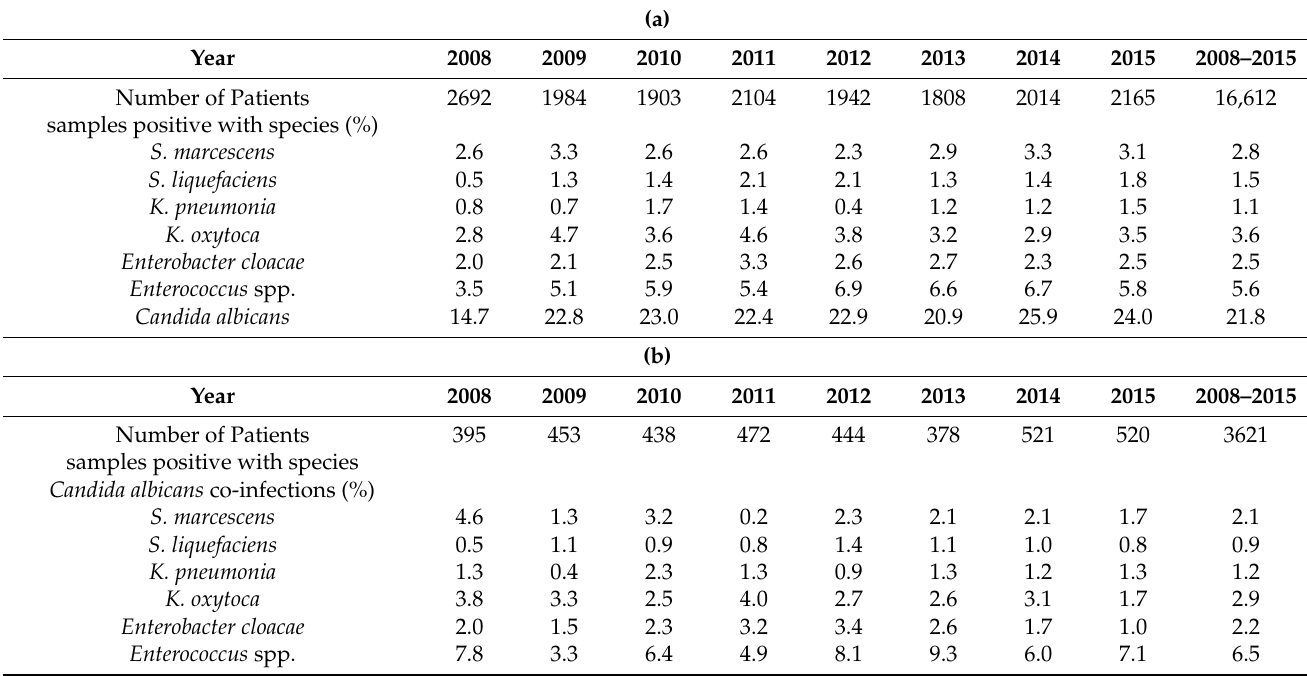
Table 1. ( a ) Prevalence of periodontitis patients ( n = 16,612) harboring the targeted commensal bacteria or candida species in Germany. ( b ) Prevalence of periodontitis patients ( n = 16,612) harboring the targeted commensal bacteria with Candida albicans